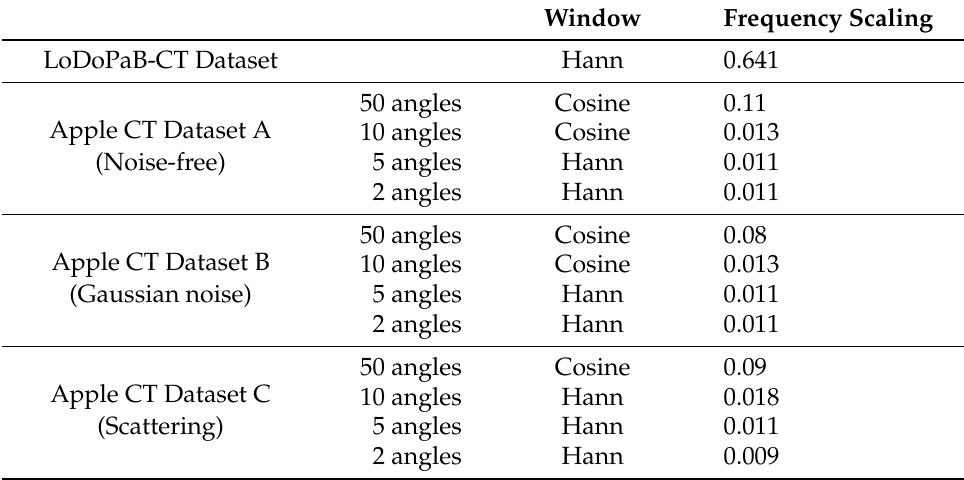
Table A1. Hyperparameters for filtered back-projection